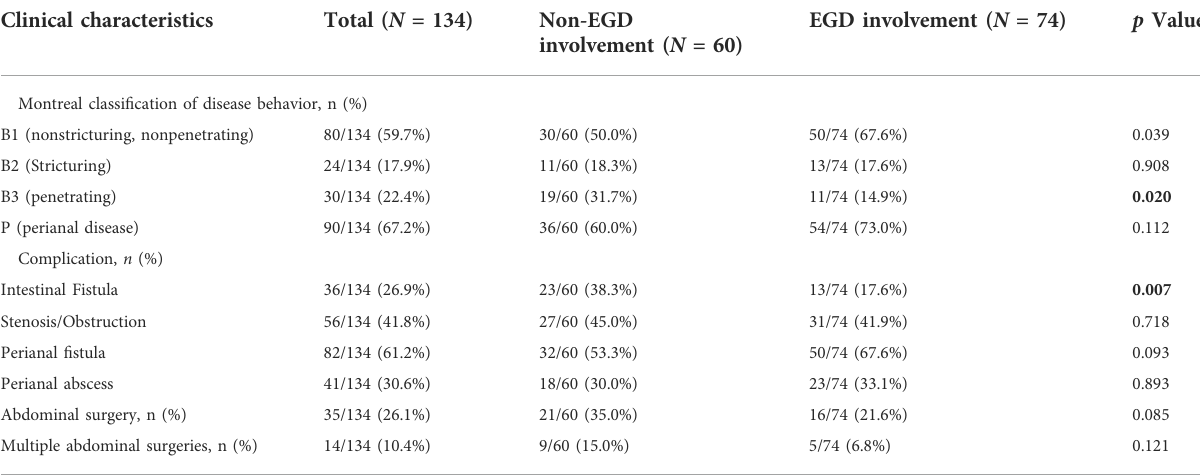
TABLE 2 Strati fi ed analysis of the clinical outcomes of L4-jejunal and L4-proximal ileal without EGD Involvement VS. EGD involvement in all the patients. Clinical